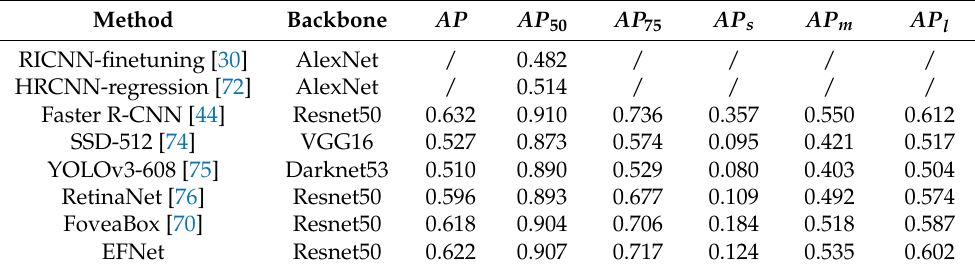
Figure 9. Qualitative examples on AIBD by EFNet. The TPs, FPs, and FNs are indicated by green, red, and yellow boxes, respectively. Table 4. Object-detection results of comparative methods on HRRSD.